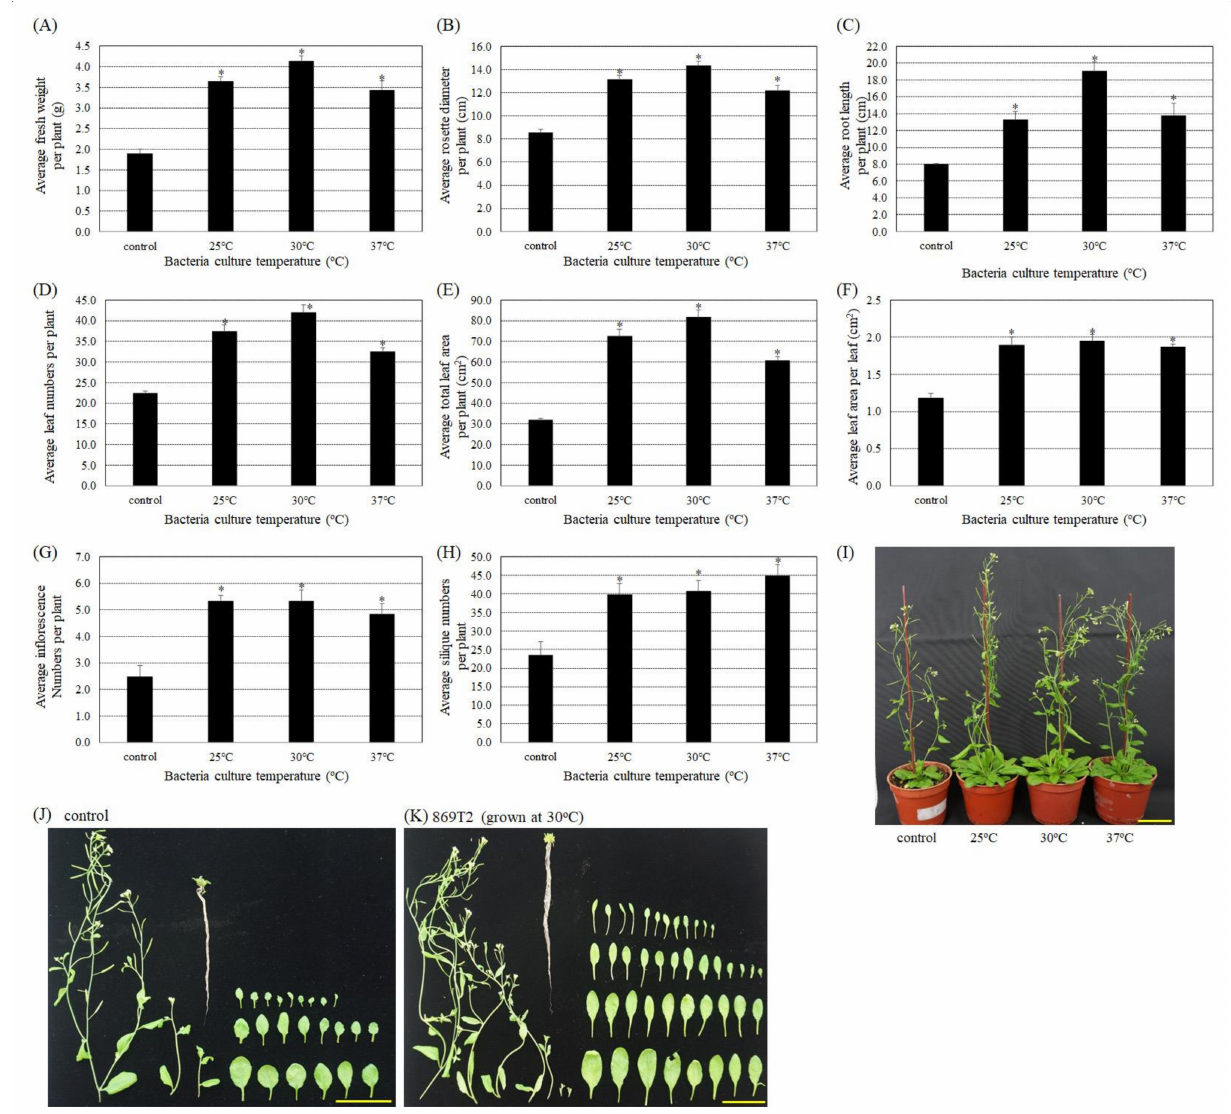
Figure 2. Inoculation of B. seminalis strain 869T2 into Arabidopsis thaliana (ecotype: Columbia) improved various growth parameters compared with mock-inoculated control plants. Strain 869T2 was grown at 25, 30, or 37 ◦ C and then used to inoculate Arabidopsis plants. Two weeks after inoculation, the average values for fresh weight ( A ), rosette diameter ( B ), root length ( C ), leaf numbers per plant ( D ), total leaf area per plant ( E ), leaf area per leaf ( F ), and the numbers of inflorescences ( G ), and siliques ( H ) per plant were determined for the inoculated and control plants. Data are mean ± SE (standard error) from at least three independent bacteria inoculation experiments. More than 20 individual plants were examined for each bacteria inoculation assay. * p < 0.05 compared with the control plants by pairwise Student t -tests. ( I ), photographs of the mock-inoculated control Arabidopsis plant and the plants inoculated with strain 869T2 cultured at 25 ◦ C, 30 ◦ C, or 37 ◦ C. Photographs of total leaves, inflorescences, and roots of the control ( J ) and the 869T2-inoculated plants ( K ). Yellow bar = 5